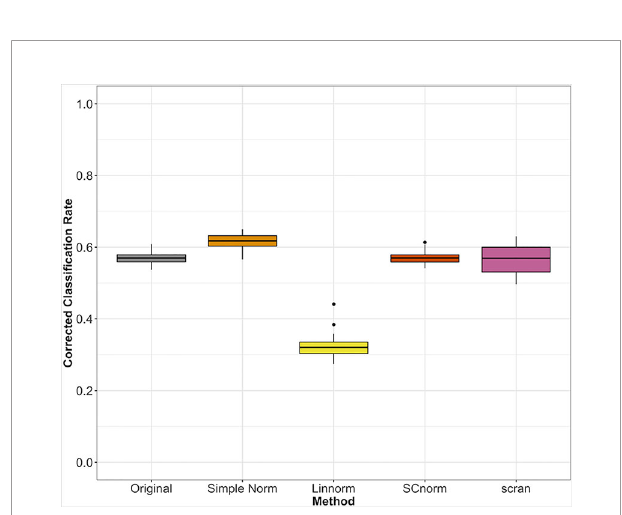
FIGURE 7 | Comparison of normalization methods using the Cohen's kappa statistic for the PBMC data set.